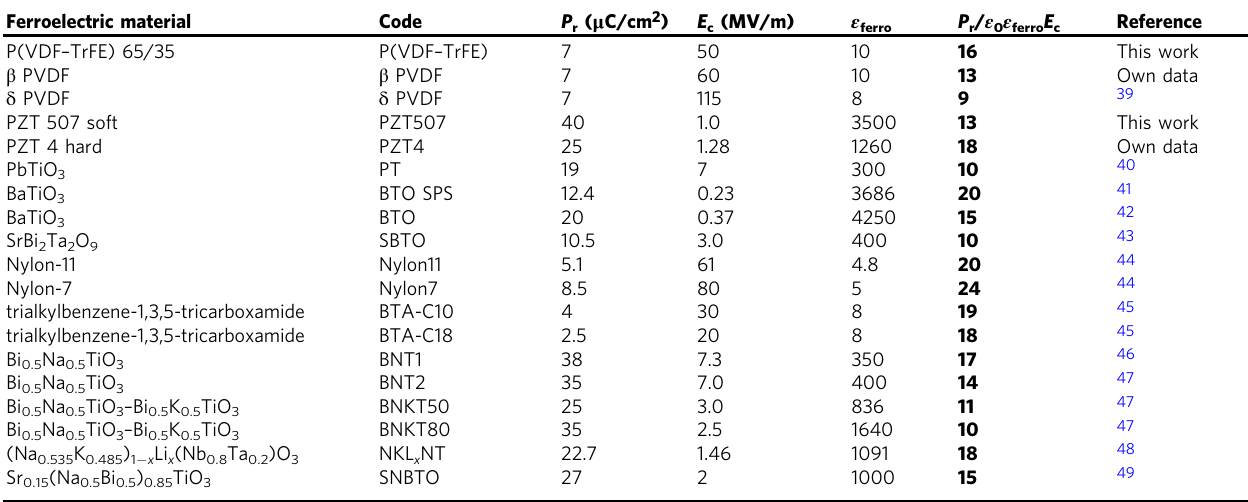
Table 1 P r / ε 0 ε ferro E c for multidomain ferroelectric materials Ferroelectric material